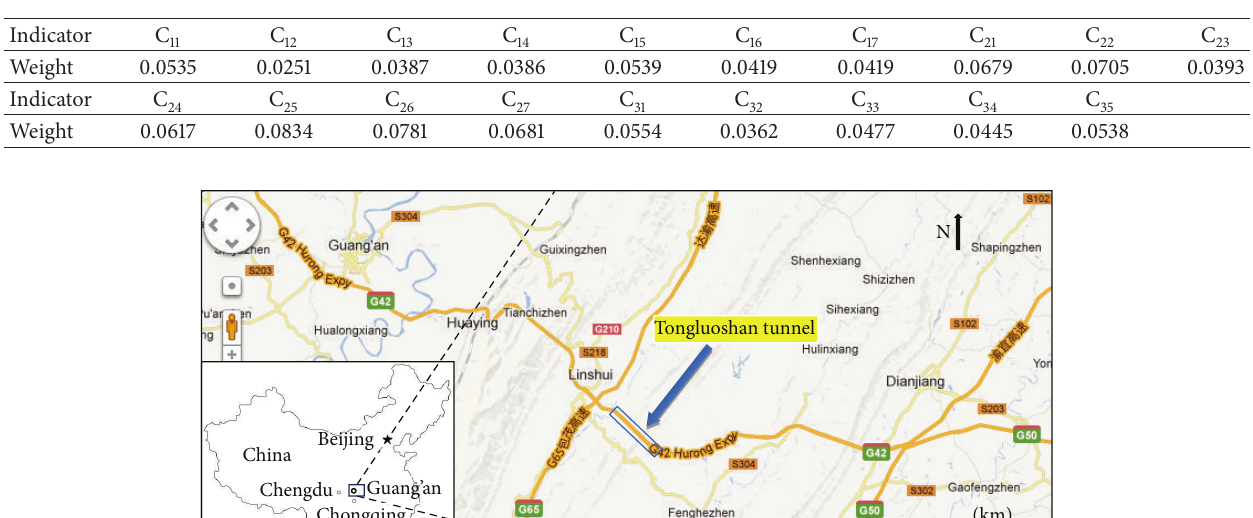
Table 3: Comprehensive weights of the indicators included in the indicator system [16].